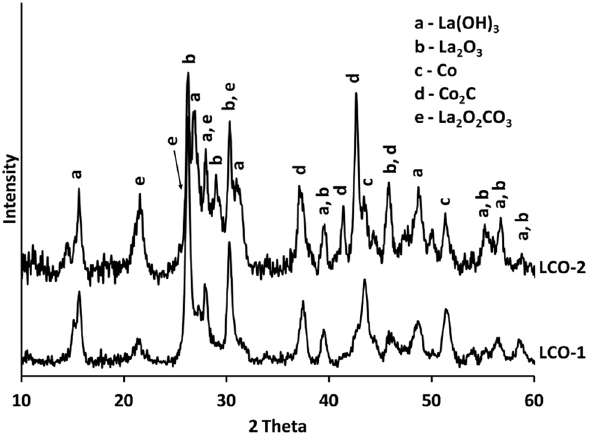
Figure 4: XRD of samples after catalytic